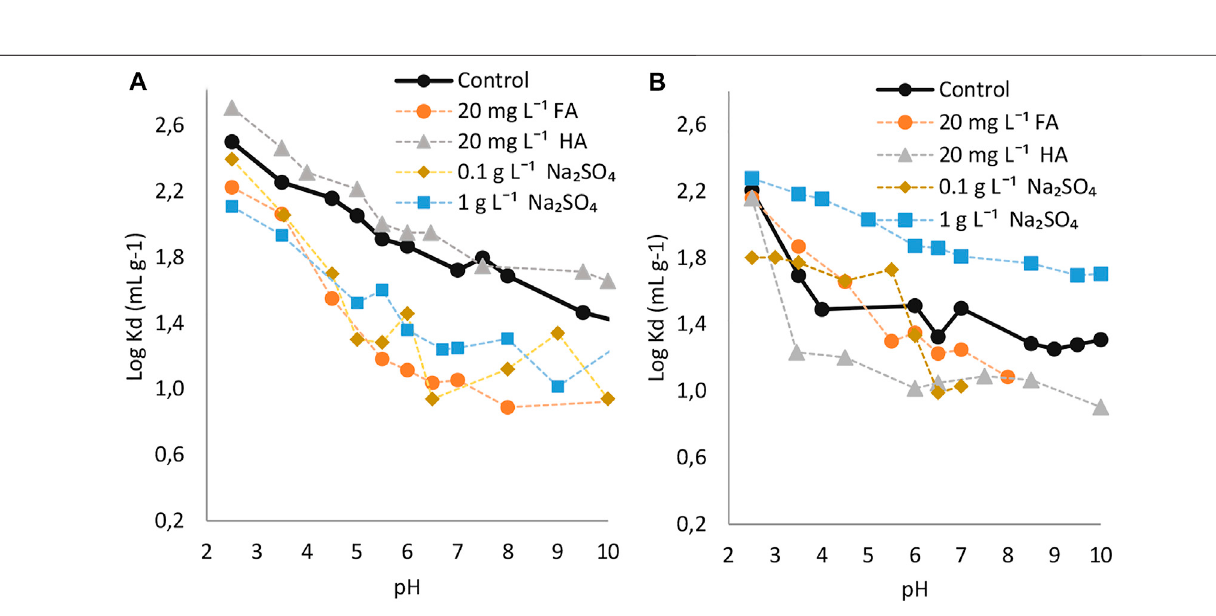
FIGURE 5 | Logarithmic sorption coef fi cients of 3/4/5-PFOS on (A) topsoil (1) and (B) subsoil (1) as function of pH and effect of dissolved humic substances or sodium sulfate. Control without adding any additives.